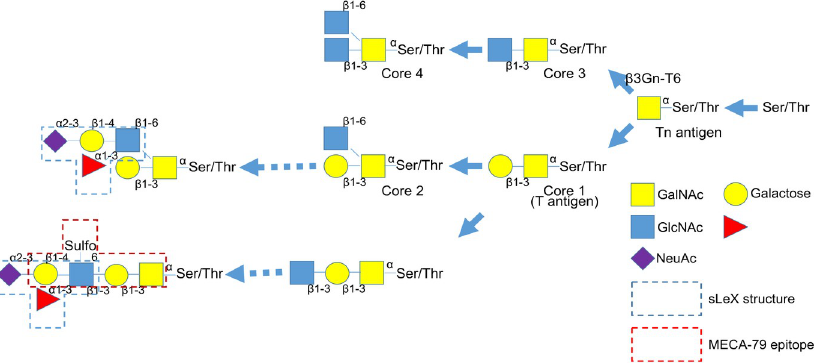
Fig 1. Biosynthetic pathways of mucin-type O -glycans. β 3Gn-T6 is the only core 3 synthetic enzyme. GalNAc: N - Acetylgalactosamine, GlcNAc: N -Acetylglucosamine, NeuAc: N -Acetylneuraminic